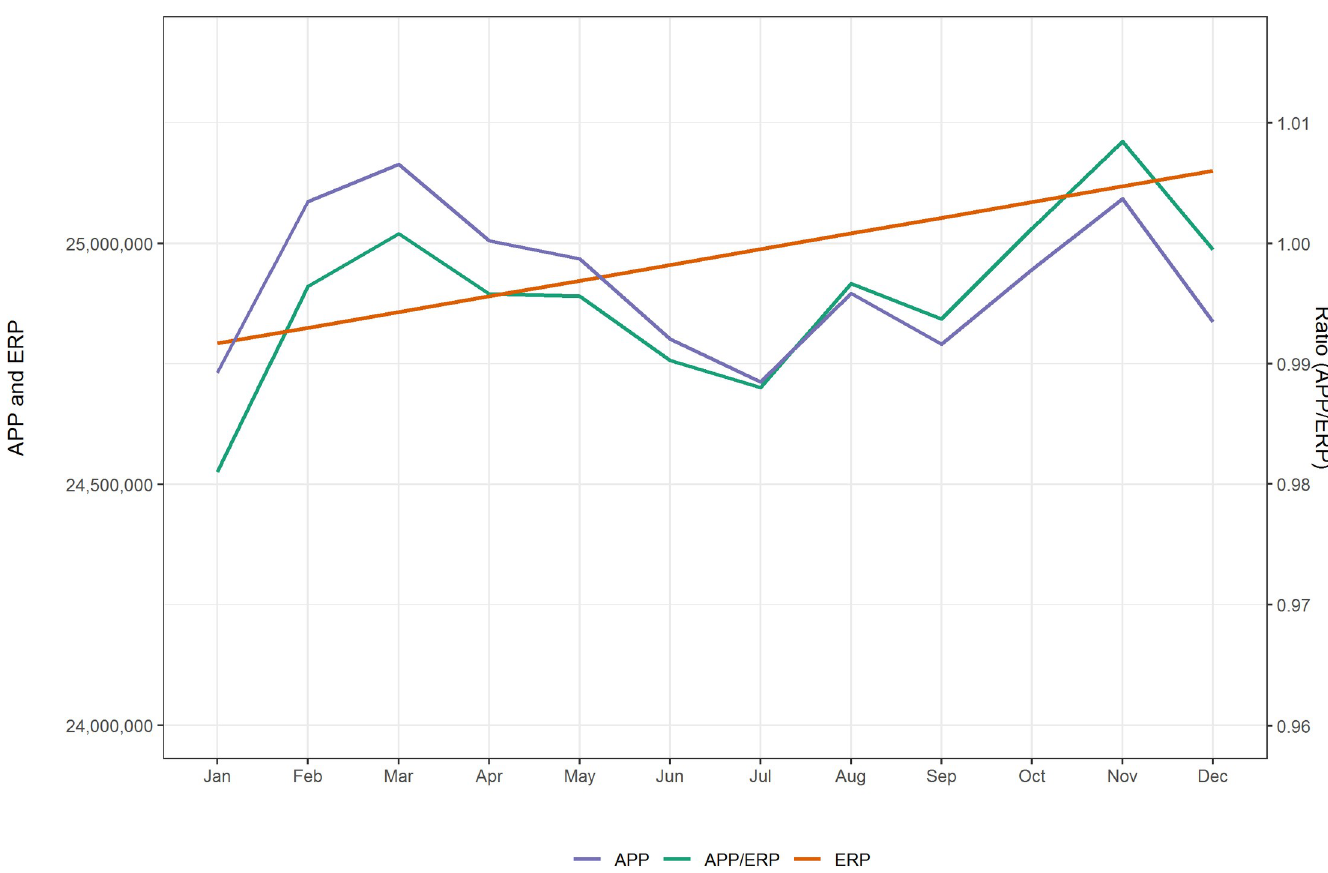
Fig 2. Population physically present and ERP, Australia, 2018. Source: authors’ own